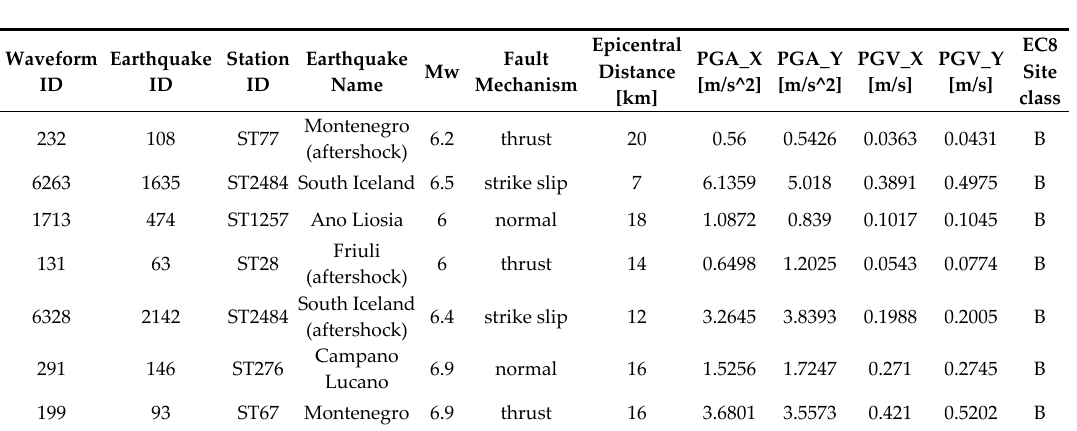
Figure 13. ( a ) Mean acceleration spectra obtained by a 7 NTC ‐ spectrum compatible accelerograms in the case of a bare structure’s SDOF ‐ equivalent system (black line) and same structure equipped with the proposed system with the following values of the coefficients α d = 2; α k = 2; α M = 10 (red dashed line); ( b ) Identification of the 7 NTC ‐ spectrum compatible accelerograms.